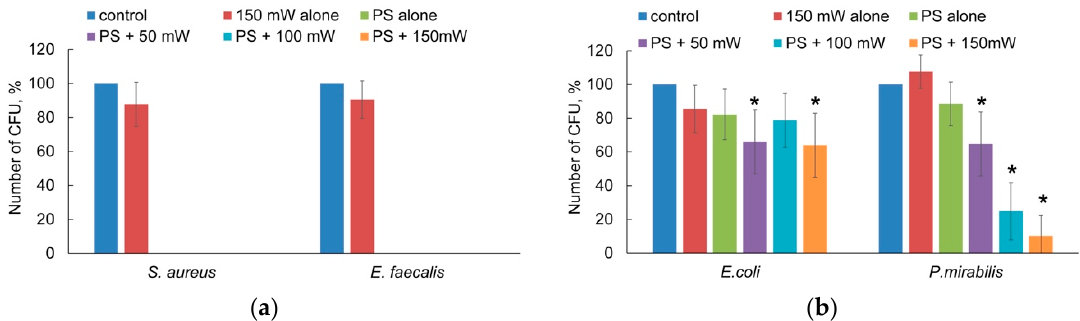
Figure 6. Results of photodynamic inactivation of Gram-positive ( a ) and Gram-negative ( b ) bacterial strains. Statistically significant differences between the corresponding control group (*) are marked.